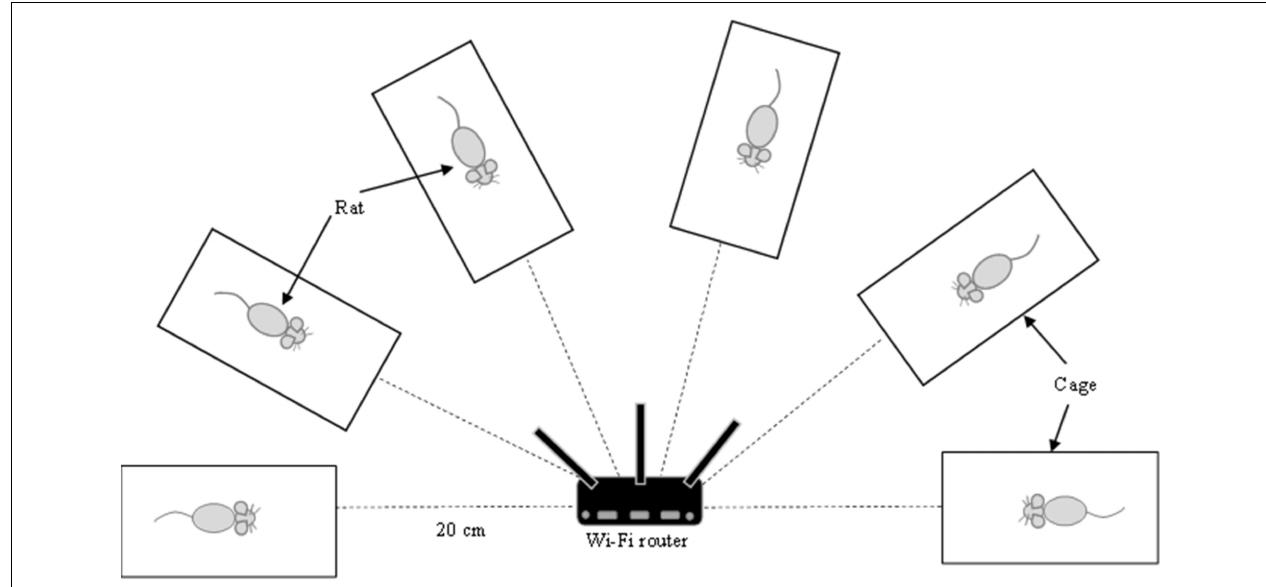
FIGURE 1 | The experimental setting for Wi-Fi exposure. Wi-Fi router was placed at 20 cm distance from the animal cages. The animal was caged individually without any movement restriction. Exposure was conducted 24 h daily for 14 consecutive weeks.